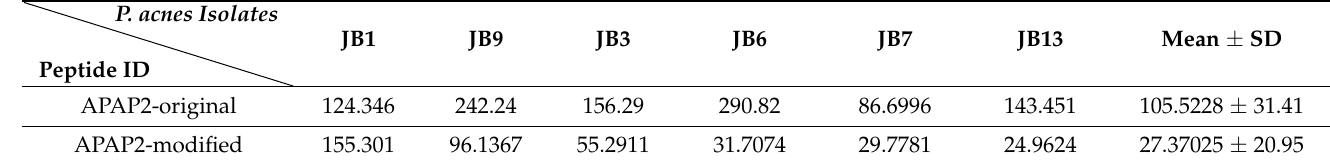
Table 3. IC50 scores of APAP2-original and APAP2-modified peptides again six P. acnes isolates treated at the concentration of 160, 80, 40, 20, 10 and 5 µ